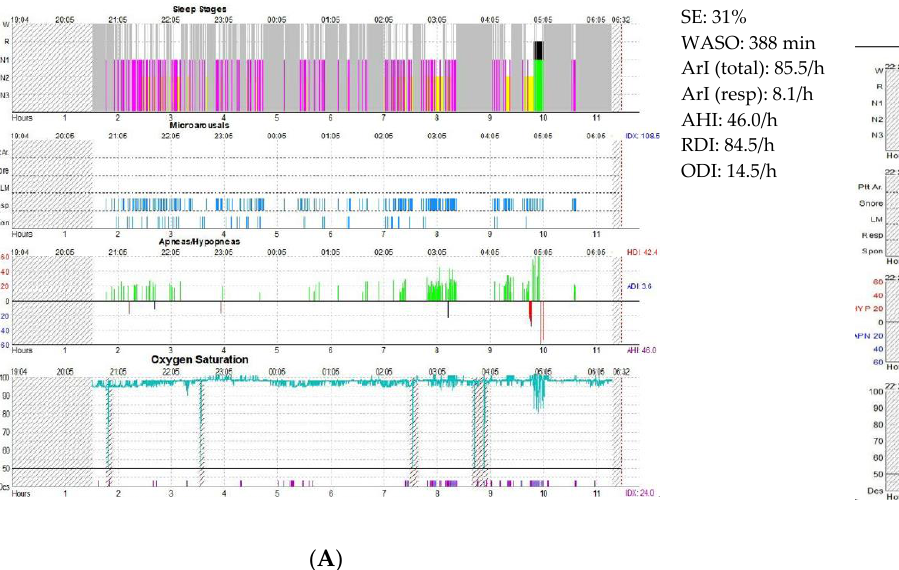
Figure 3. Changes in sleep architecture following treatment with automatic positive airway pressure in a patient with Parkinson’s disease and severe obstructive sleep apnea. The graphs represent (from top to bottom): sleep stages, microarousals, respiratory events, and oxygen saturation. ( A ) Polysomnography before treatment that shows reduction in sleep efficiency (SE), substantial sleep fragmentation with many arousals, increased wake after sleep onset (WASO), reduced slow wave sleep, and prolonged REM latency with only one REM period occurring at the end of the night. ( B ) Polysomnography performed on automatic positive airway pressure. It shows improvement of SE, WASO, arousals, and overall sleep architecture with increased proportion of slow wave and REM sleep and normal REM latency (60 min). AHI, apnea-hypopnea index; LM, leg movement; RDI, respiratory disturbance index; and ODI, oxygen desaturation index as defined by a drop in pulse oxygen saturation of 3 % or greater.